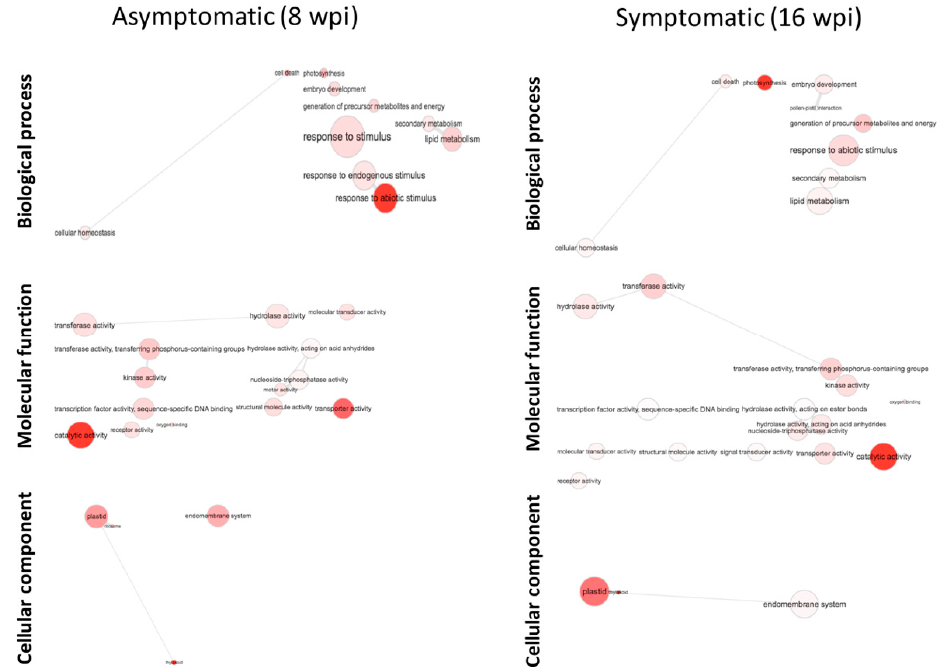
Figure 7. Functional gene-network analysis of DEGs identified by GO enrichment. Interactive graph was generated using web-tool REVIGO (available online: http://revigo.irb.hr/). The web-tool agriGO (available online: http://bioinfo.cau.edu.cn/agriGO/analysis.php) was used to obtain a Singular Enrichment Analysis of the Gene Ontology (GO) terms. In the plot, bubble color and size indicates the p -value generated and GO term frequency, respectively. GO terms sharing high similarity are linked by edges, where similarity degree is indicated by line width.